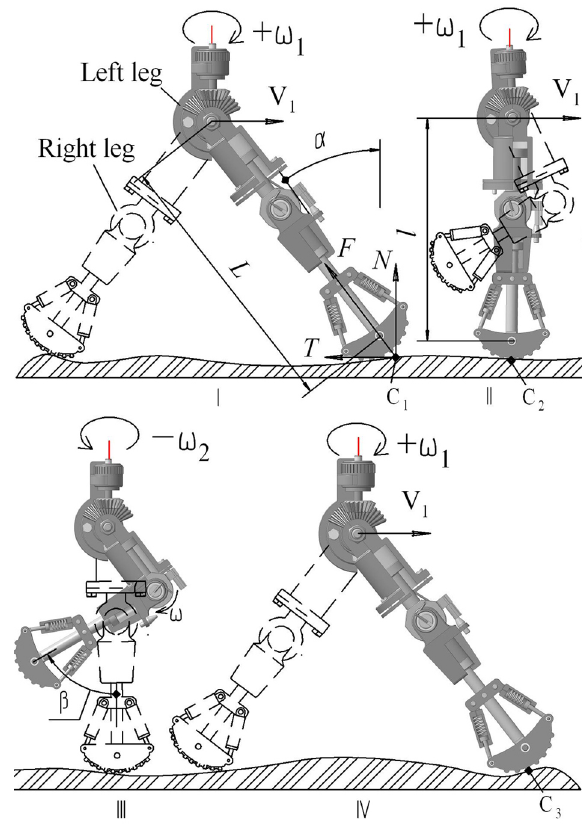
Figure 4. Stages of movement of the legs of a walking